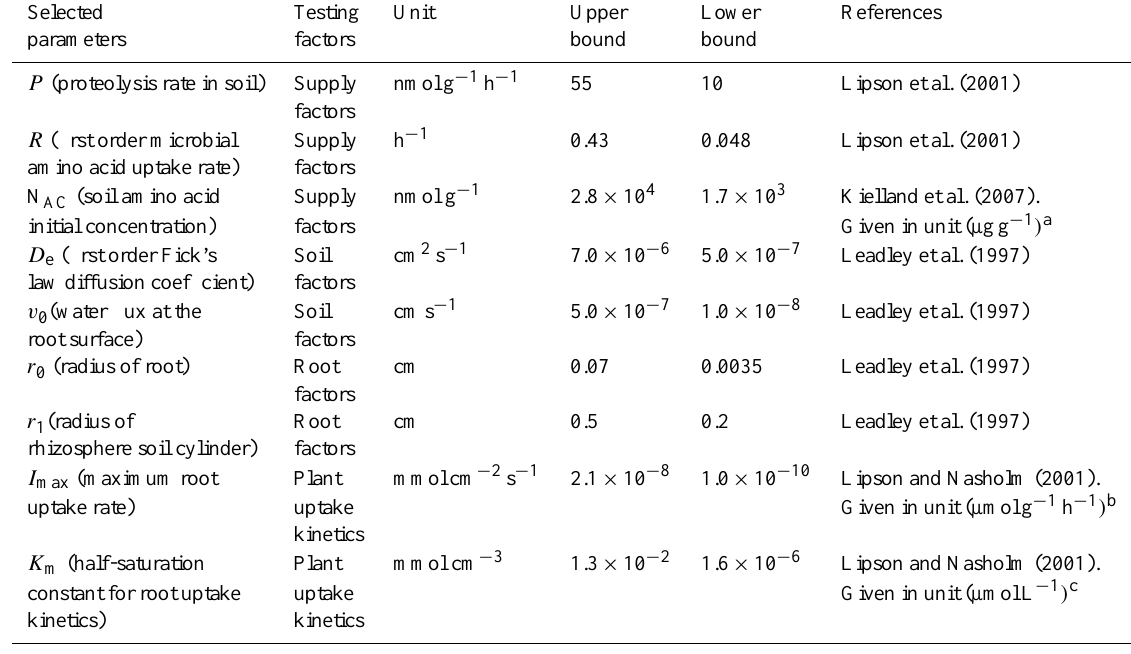
Table 4. Upper and lower bounds of the selected parameters for the global sensitivity